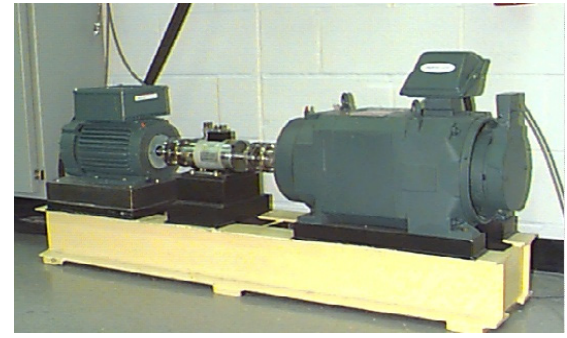
Figure 5. Description of the experimental platform.